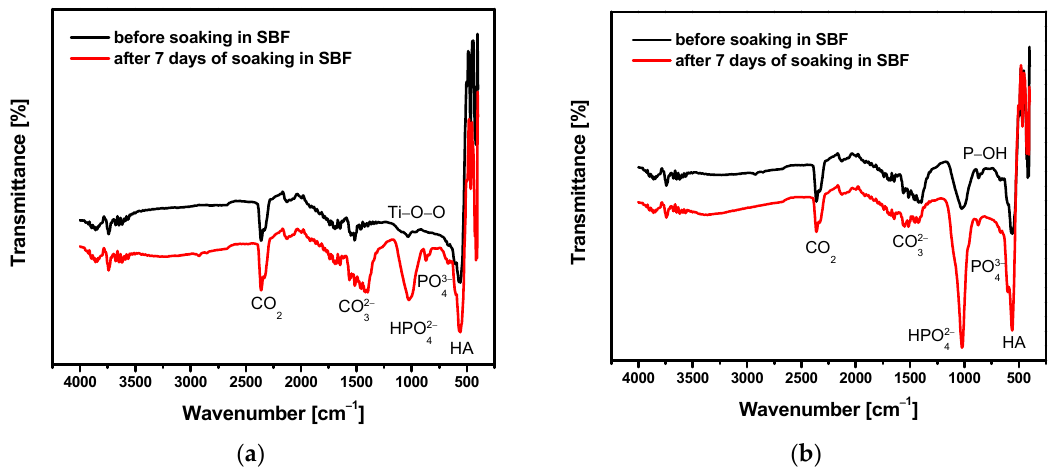
Figure 12. ATR-FTIR spectrum collected after 7 days of immersion in SBF at 36.6 °C for: ( a ) CpTi G4 substrate; ( b ) CaP coating deposited at − 3 V for 30 min at 20 °C.